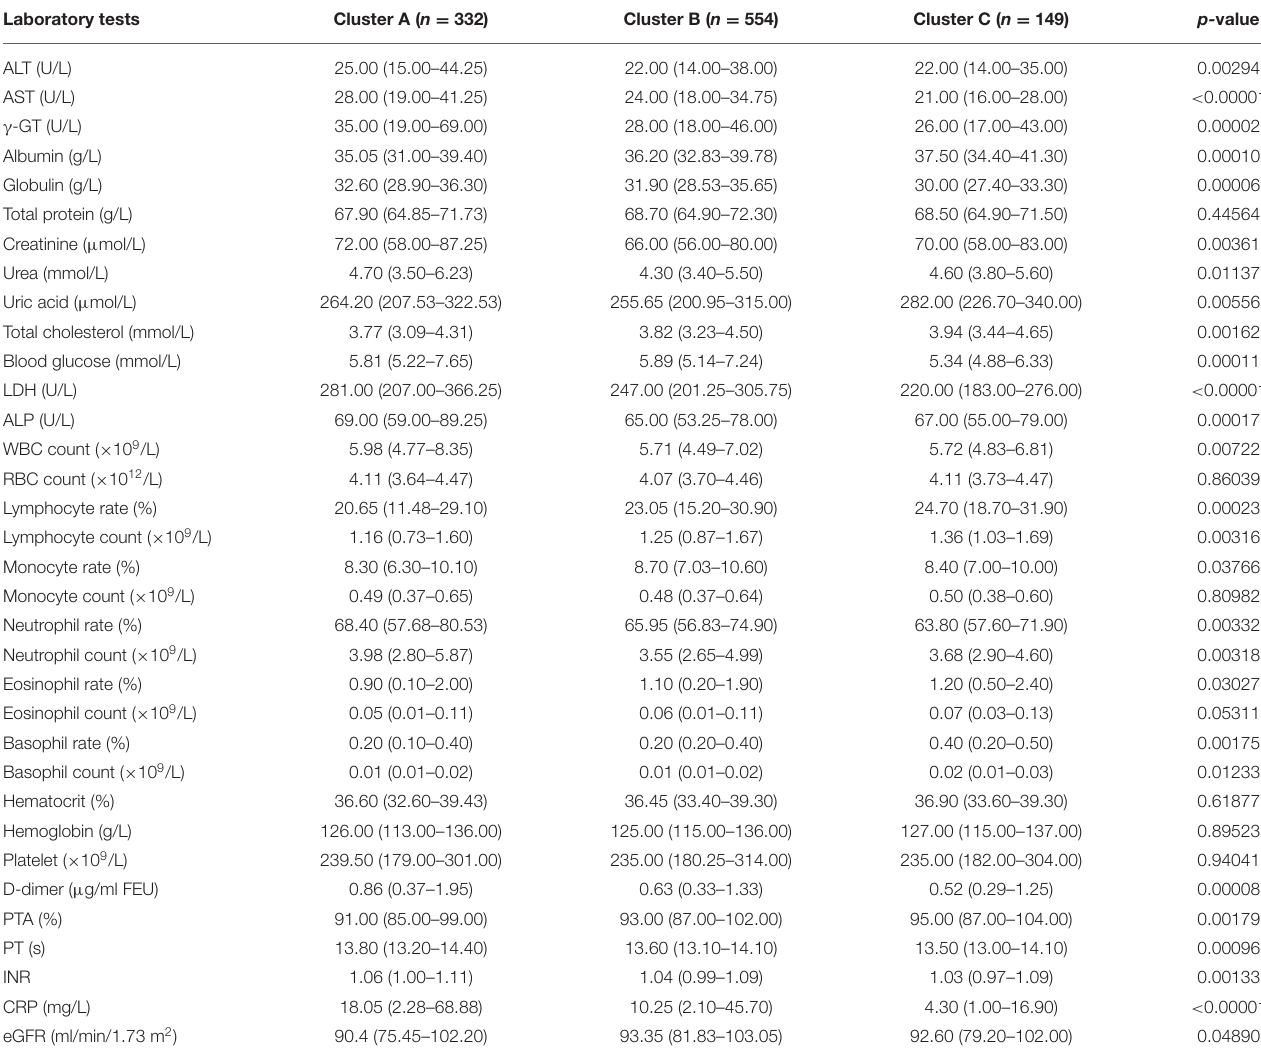
TABLE 5 | Laboratory findings of three COVID-19 clusters identified by Factor Analysis of Mixed Data-based cluster